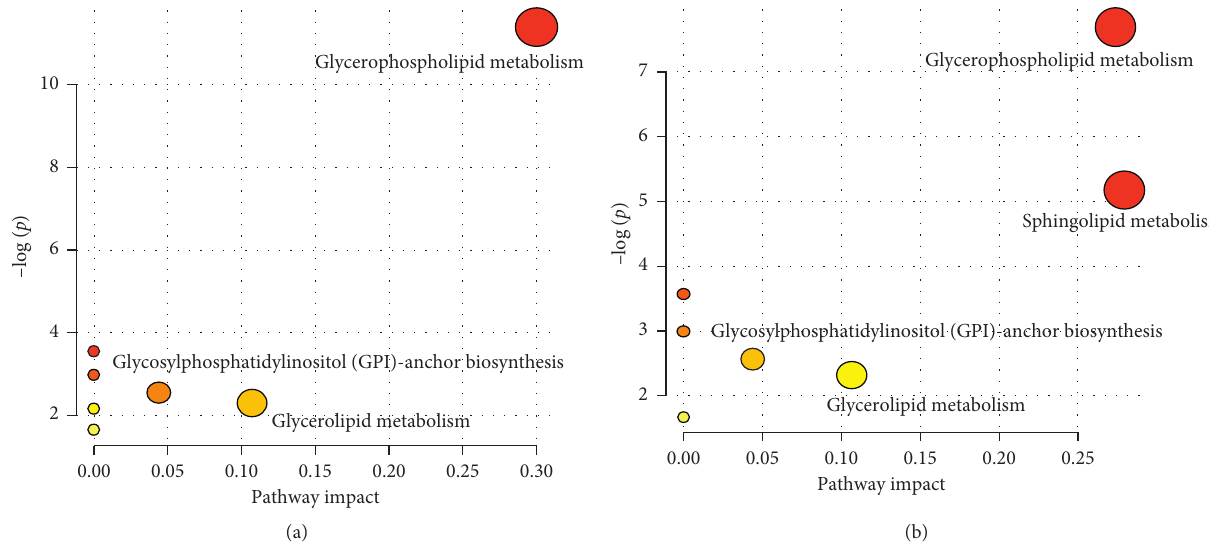
Figure 5: Metabolic pathway analysis: (a) for 1h group and (b) for 24h